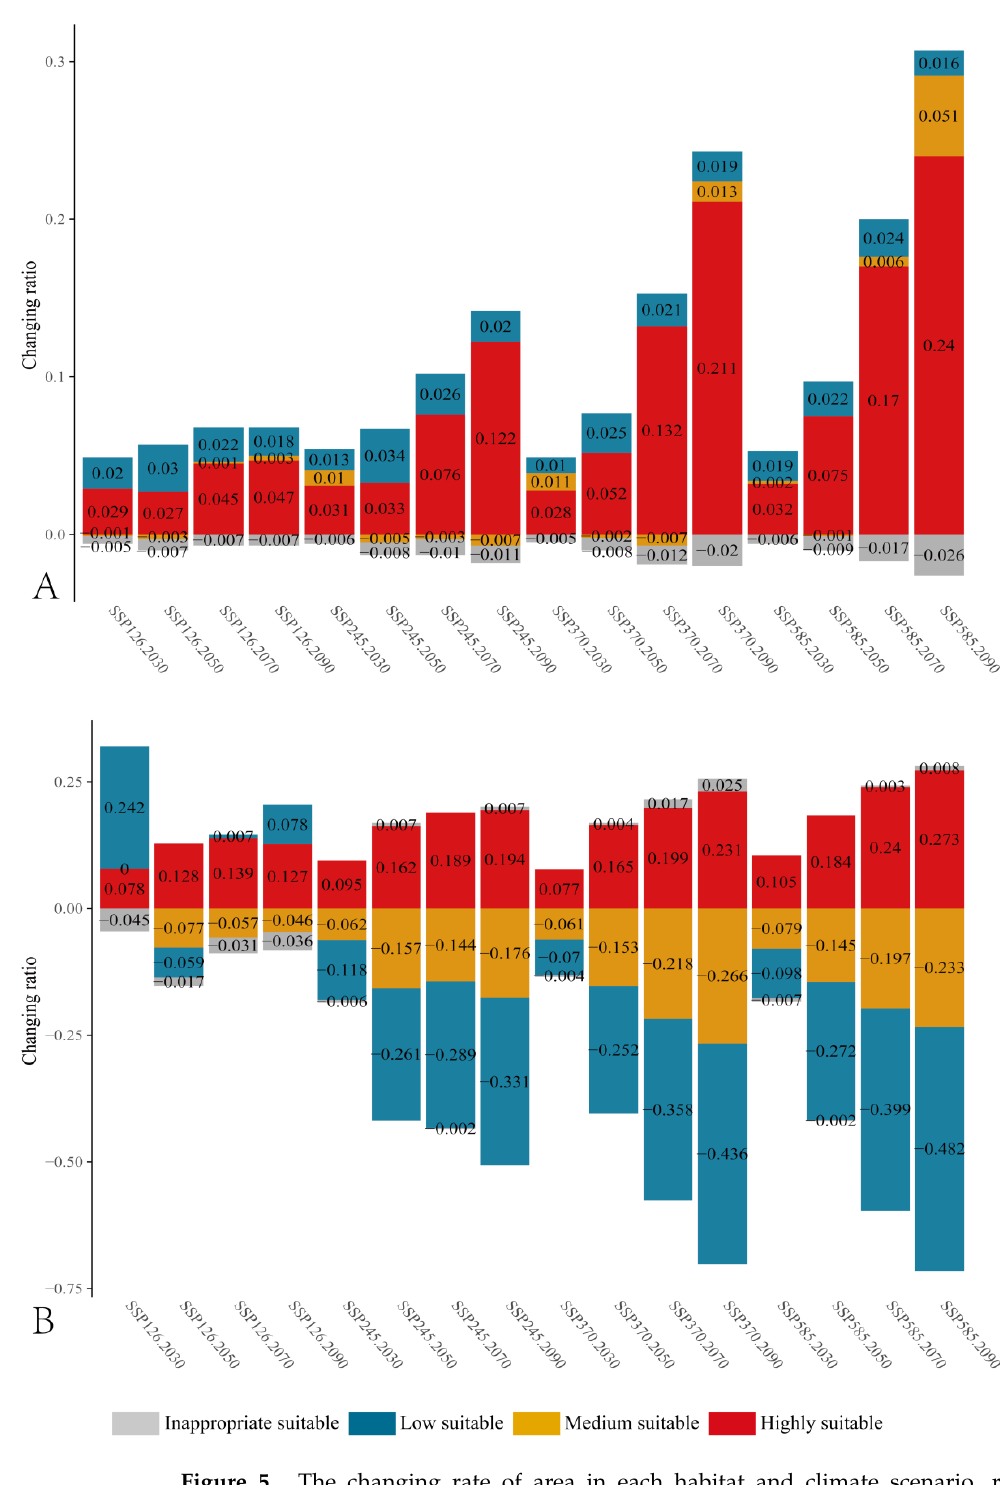
Figure 5. The changing rate of area in each habitat and climate scenario, rate = (selected– current)/current. ( A ) The changing rate of habitats areas in AH (abiotic and host factors) strategy; and ( B ) the changing rate of habitats areas in HO (host factors only) strategy. And the positive value rep- resents an increase in area, the negative value represents a decrease in area compared to the